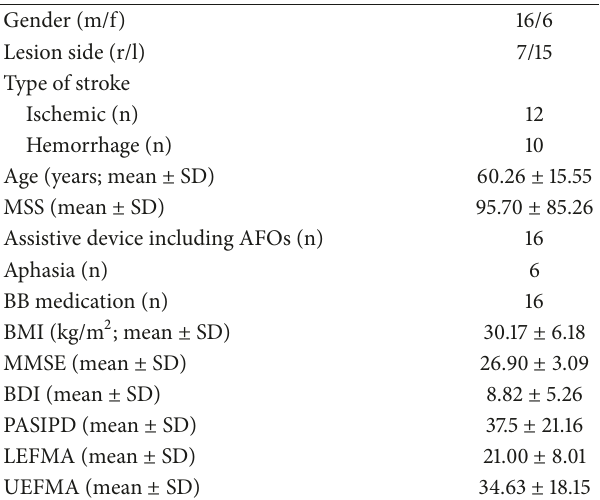
Table 1: Descriptive